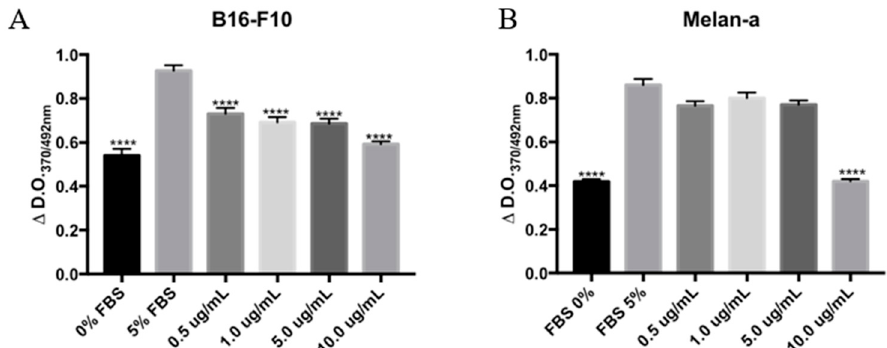
Figure 5. CMS-2 inhibits proliferation of melanoma and melanocyte cell line. Cell proliferation was evaluated by incorporation of bromodeoxyuridine (BrDU) assay after 24 h of CMS-2 treatment (0.5–10 µ g/mL). DNA synthesis, represented by the difference in absorbance between 370 and 492 nm for: B16-F10 ( A ); and Melan-a ( B ). **** p < 0.001, analysis of variance, Bonferroni post-test compared to 5% fetal bovine serum (FBS) positive control. The negative control was 0% FBS.